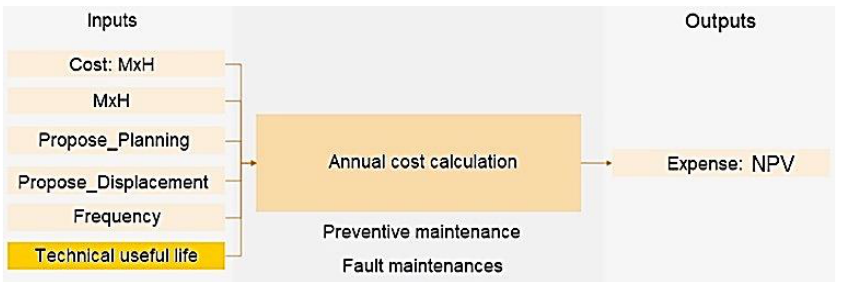
Figure 3. Variables for calculating equipment operating costs [authors].